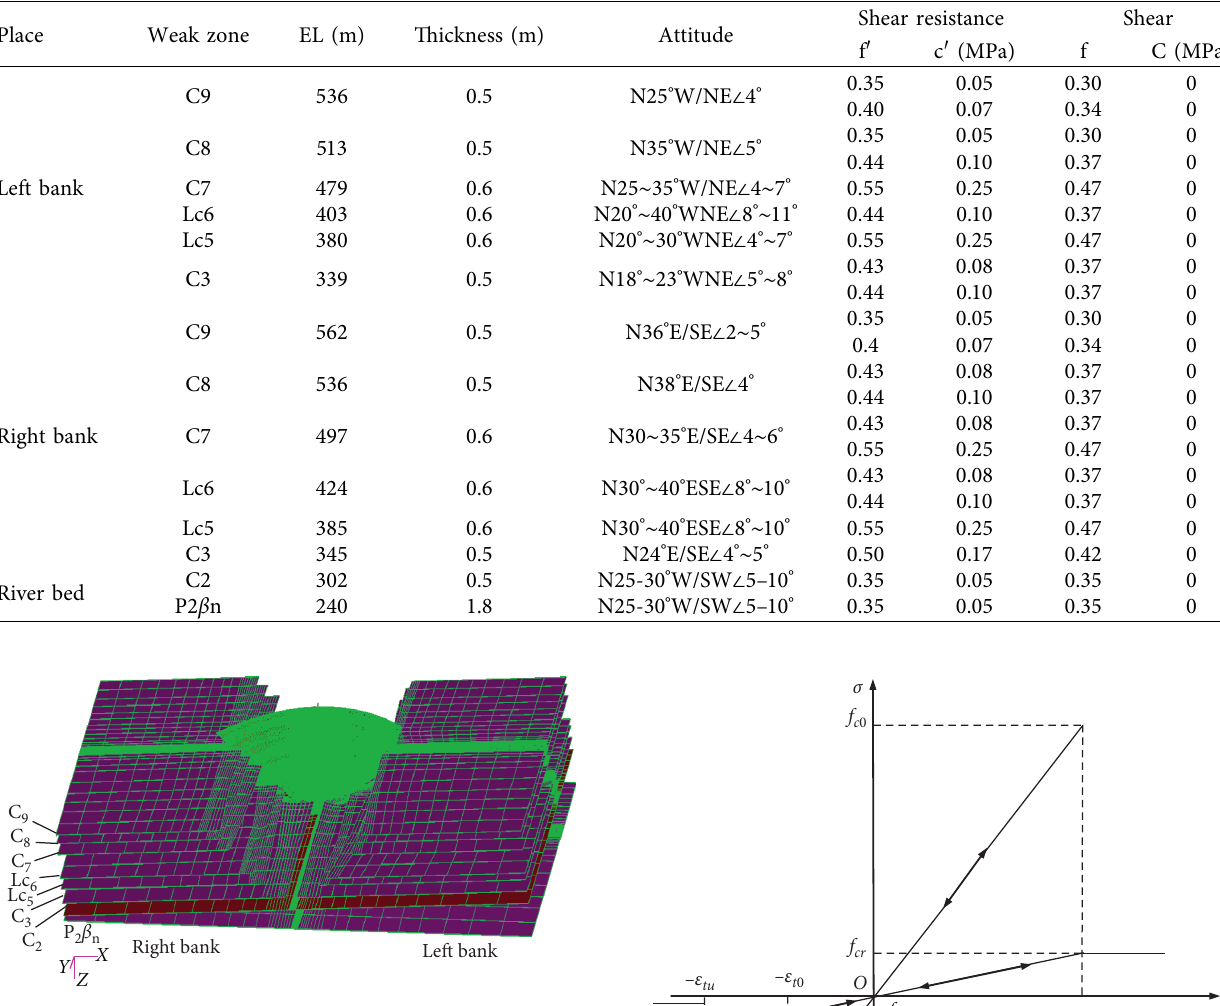
Table 1: Characteristics of dislocation zone in the interlayer of the dam area.